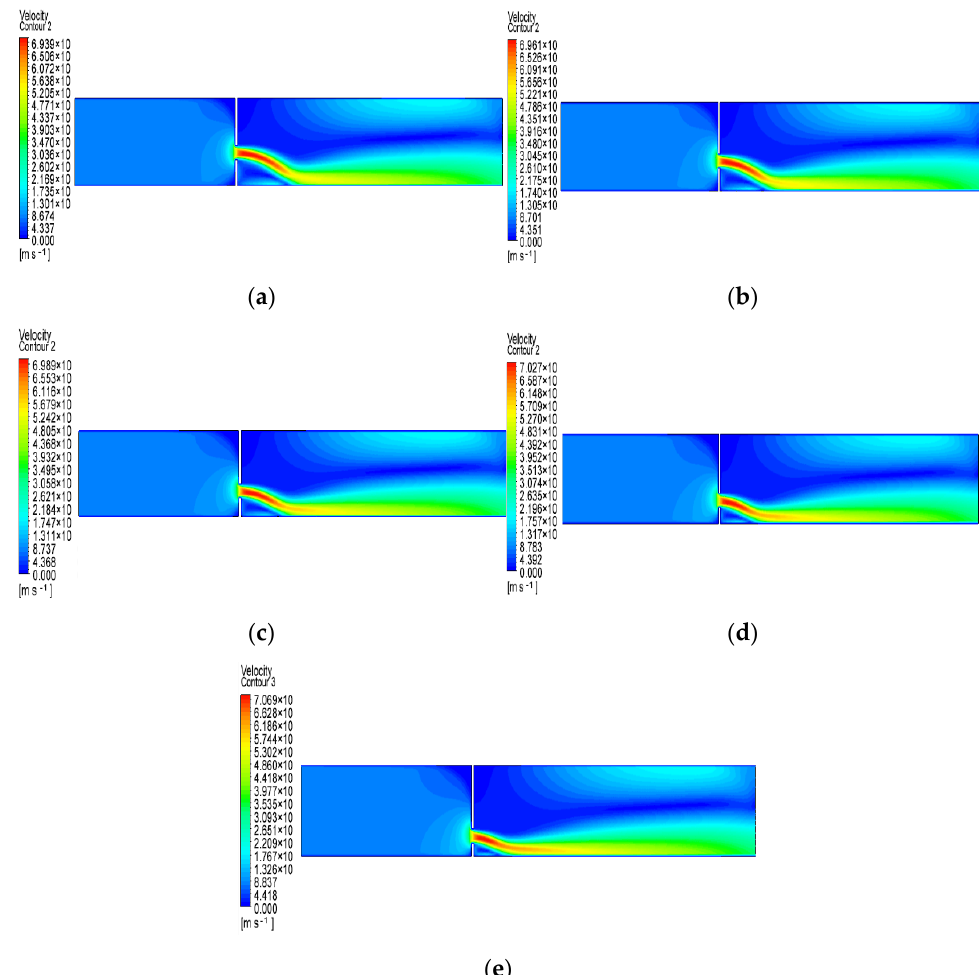
Figure 8. Velocity cloud diagrams of the same air-speed and different personnel-door positions. ( a ) 200 mm; ( b ) 400 mm; ( c ) 600 mm; ( d ) 800 mm; ( e ) 1000 mm.